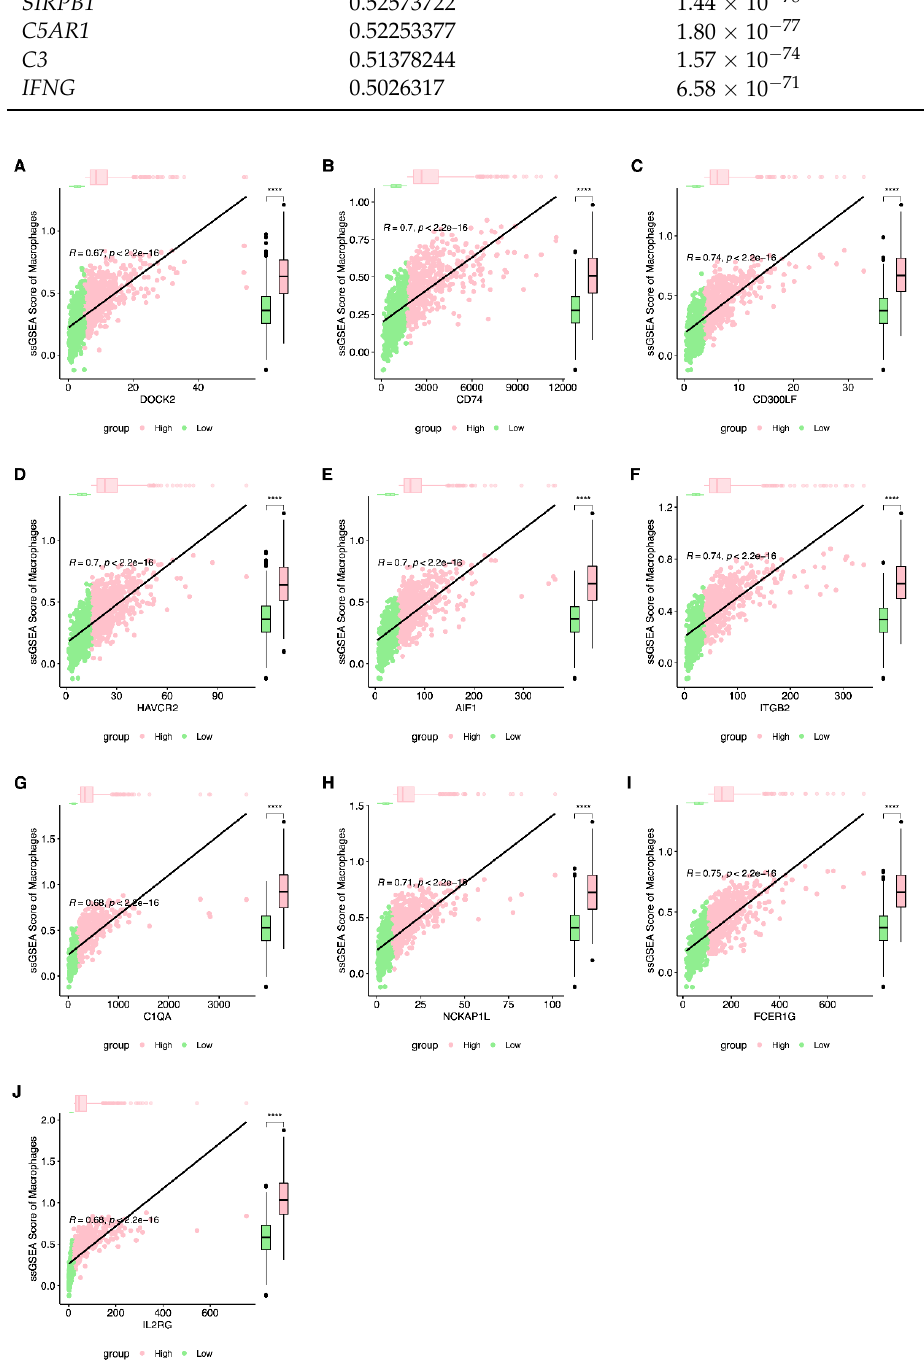
Figure 1. The correlation of expression of macrophage and macrophage enrichment score with top 10 phagocytic factors. ( A ) DOCK2 ; ( B ) CD74 ; ( C ) CD300LF ; ( D ) HAVCR2 ; ( E ) AIF1 ; ( F ) ITGB2 ; ( G ) C1QA ; ( H ) NCKAP1L ; ( I ) FCER1G ; ( J ) IL2RG . (**** p <